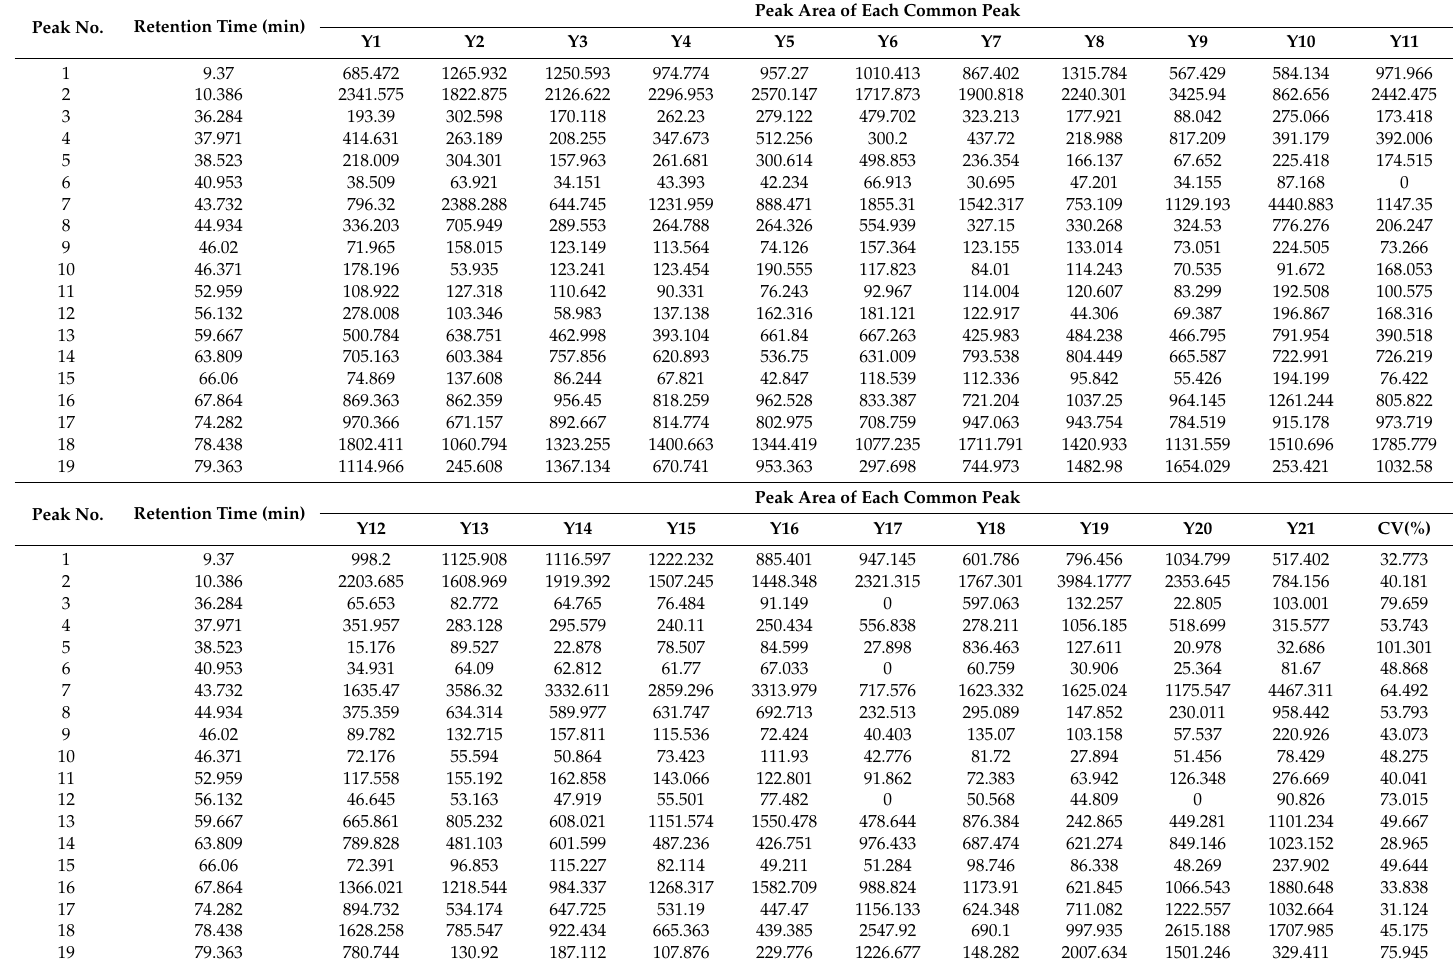
Table 1. The areas of 19 common peaks from 21 batches of toad venom extracts